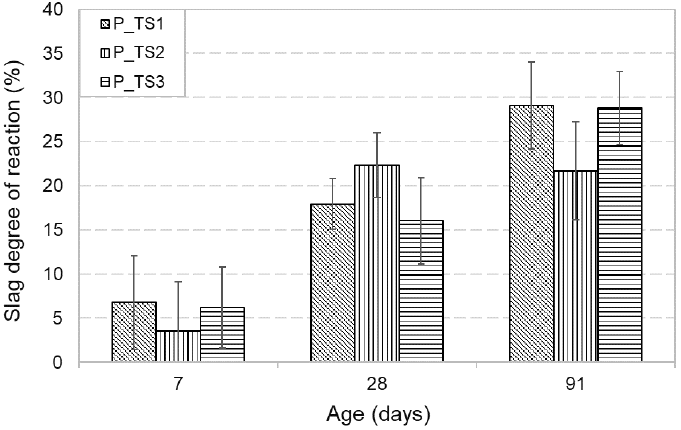
Figure 9. The slag degree of reaction in different slag-blended pastes up to the age of 91 days.